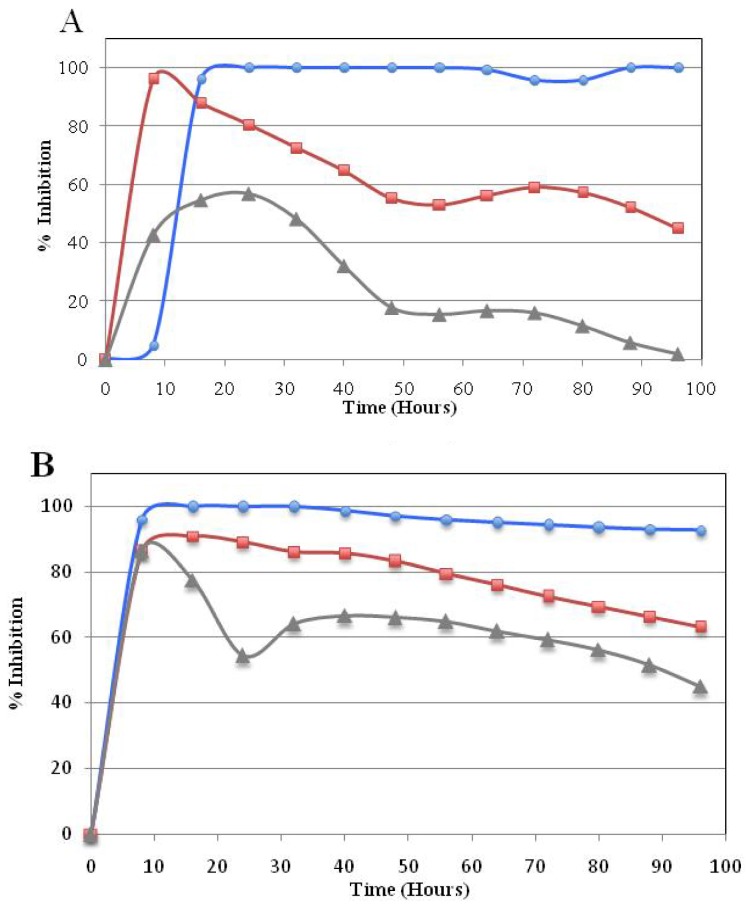
Real-time cell growth surveillance in the presence of compound 5a. The compound 5a was applied on HUH7 (A), HCT116 (B) and MCF7 (C) cell lines in GI100(
), GI50(
), and GI25 (
) concentrations, which were calculated from Table 2. Real-time cell growth surveillance by the cell impedance-based xCELLigence data acquisition system was performed in triplicate.